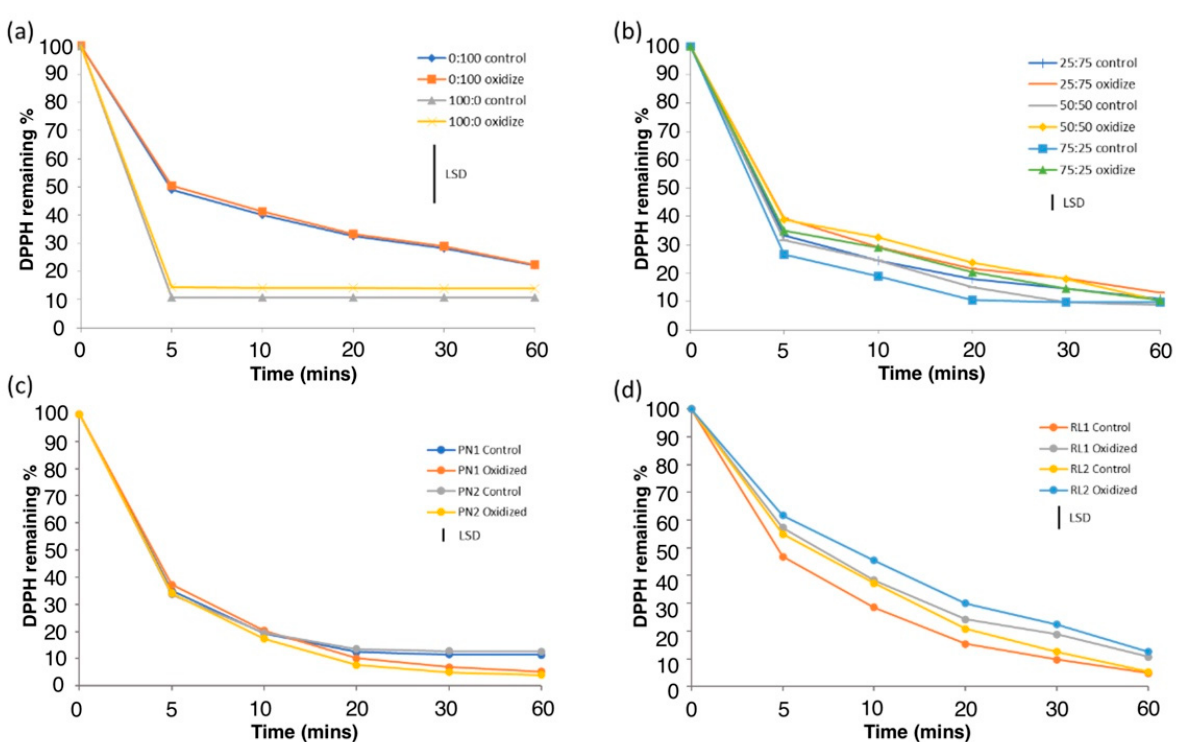
Figure 3. The DPPH remaining percentage of control and oxidized fl avonoid model ( a , b ) and wine lees ( c , d ). The black bar in the fi gure represents the least signi fi cant di ff erence (LSD) of the replicate lees ( c , d ). The black bar in the figure represents the least significant difference (LSD) of the replicate subsamples samples (n = 3) and measured in triplicate. subsamples samples (n = 3) and measured in